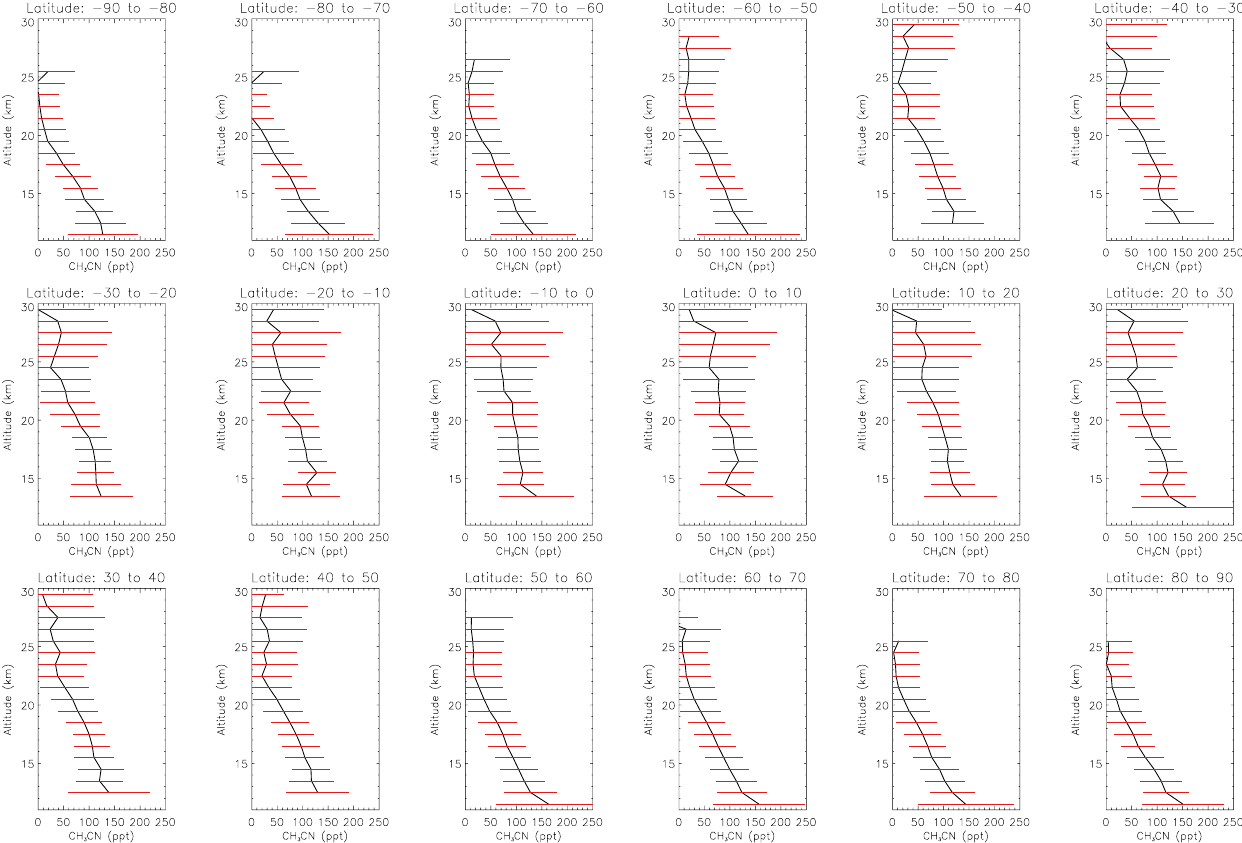
Fig. 2. Median ACE CH 3 CN profiles in 10 ◦ latitude bins for the complete time period of the available ACE measurements (2004–2011), after filtering out occultations that sample biomass burning plumes, occultations located inside or on the edge of a polar vortex, and significant VMR outliers. Errors at each altitude are taken as one MAD of the VMR distribution for the filtered